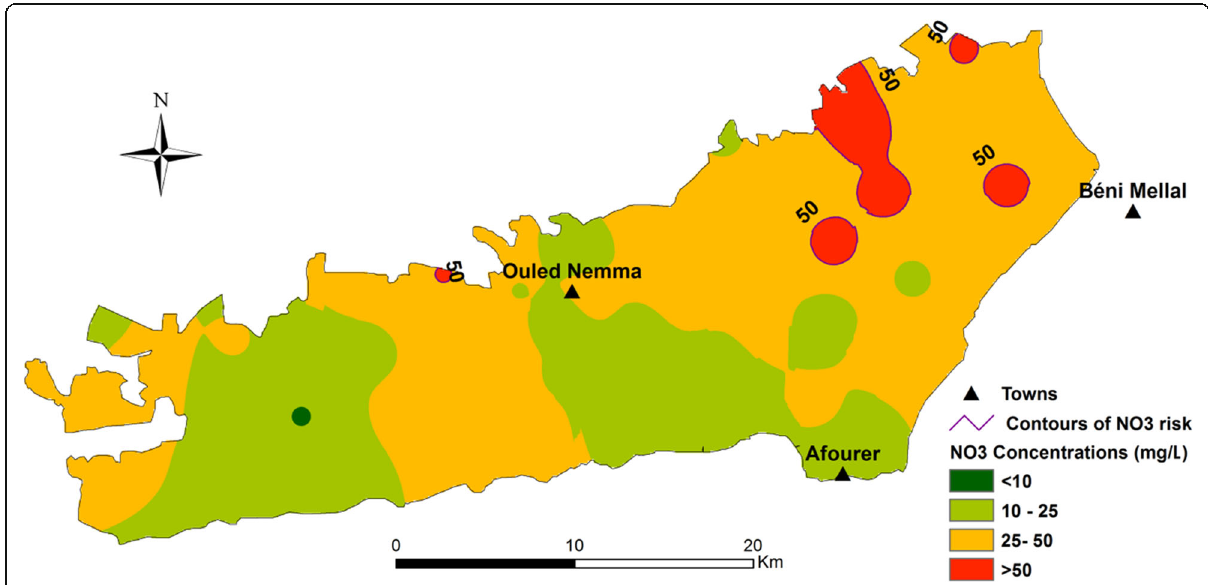
Fig. 2 Spatial distribution of groundwater nitrates